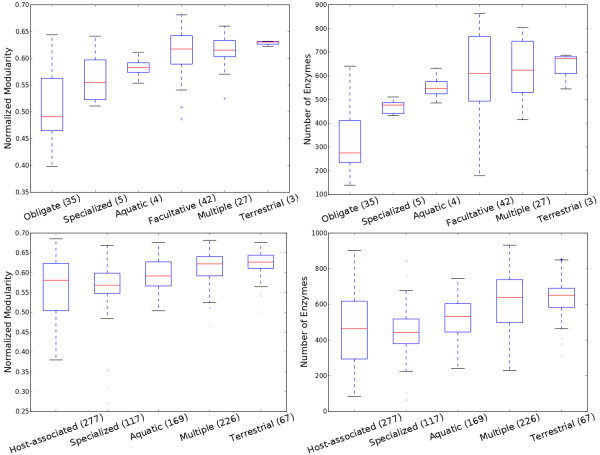
Environment variability and modularity. (Top row) On a small data set of 116 bacteria, habitat variability vs. normalized modularity (left) (Kruskal-Wallis H-test p = 5.48 × 10−11) and habitat variability vs. the number of enzymes (right) (Kruskal-Wallis H-test p = 1.03 × 10−10). (Bottom row) On a large data set of 806 microbes, habitat variability vs. normalized modularity (left) (Kruskal-Wallis H-test p=6.51×10−26) habitat variability vs. the number of enzymes (Kruskal-Wallis H-test p = 1.03 × 10−30).